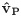
Comparison of the principal components derived from ln(RNM) and ln(BPND) for PD patients and HCs.Note that the principal components, PCP (a) and PCN (b), are the projections of the data points along the directions v^P and v^N, respectively, in Fig 2. Overlapping data points are slightly offset horizontally so that all points are visible. The closed circles and error bars indicate the mean and standard deviation for each group. The "*" indicates a significant difference between the PD and HC groups (P<0.05).